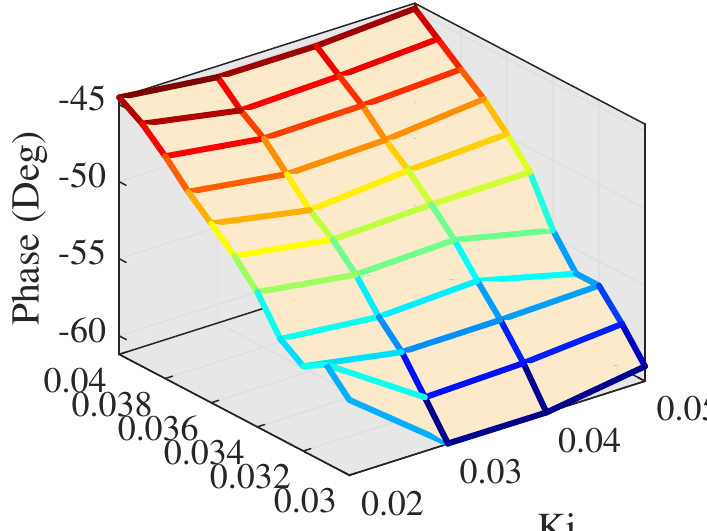
Figure 22. Phase lag at low level PI.